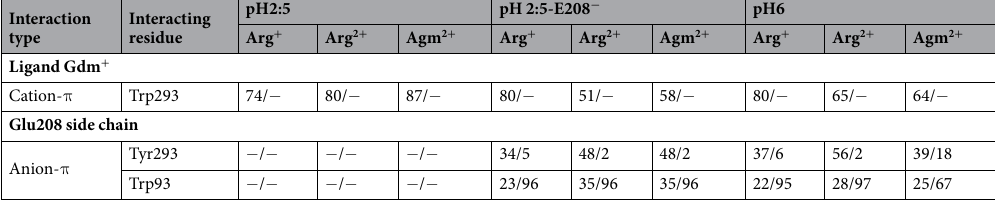
Table 1. Percentages of specific interactions formed by the Gdm + group of the considered ligand and by Glu208 in the different classical trajectories under varying pH conditions. Each pair of numbers (whenever it appears) corresponds to a calculation performed on two portions of the MD trajectories: the first number includes the conformations featuring the ligand in the binding site and the second, those where the ligand is absent from the binding site. This distinction is based on the location of the center of mass of the ligand along the main axis of the transporter (between 0 and 6 Å or beyond 6